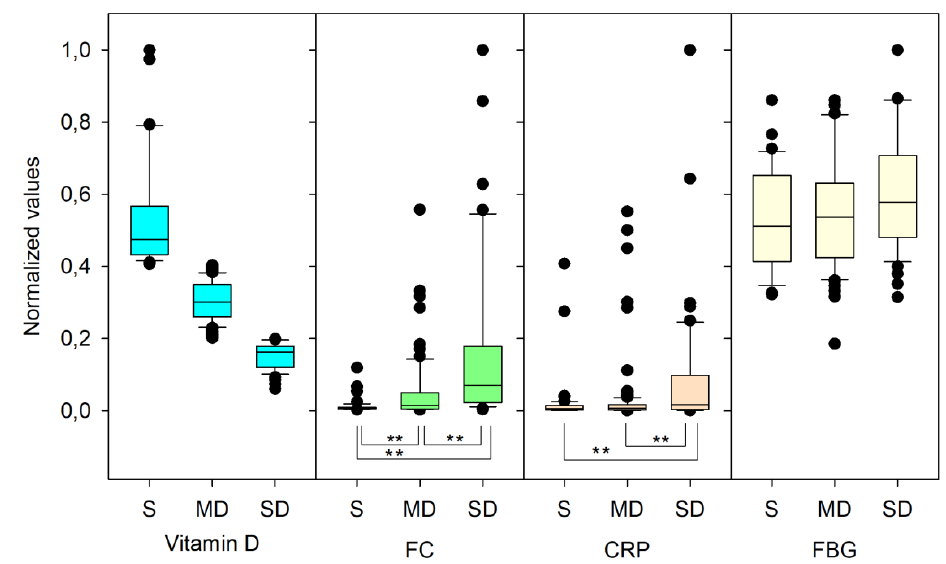
Figure 7. Box and whisker plot using normalised values of inflammatory markers depending on vitamin D levels. (**) correspond to significant differences at 99% (Dun’s test for multiple comparisons on the Kruskal–Wallis test).